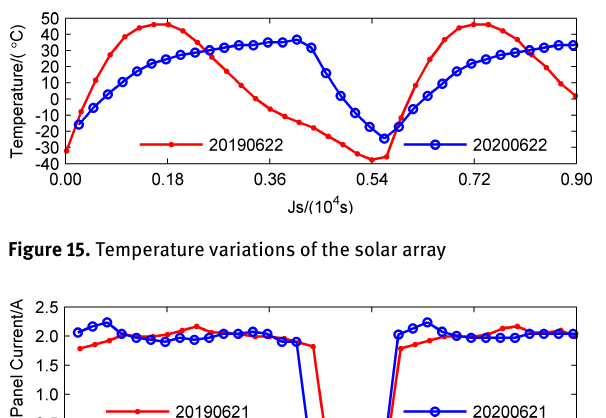
Figure 12. Simulations of the yaw angular velocity with orbital elements